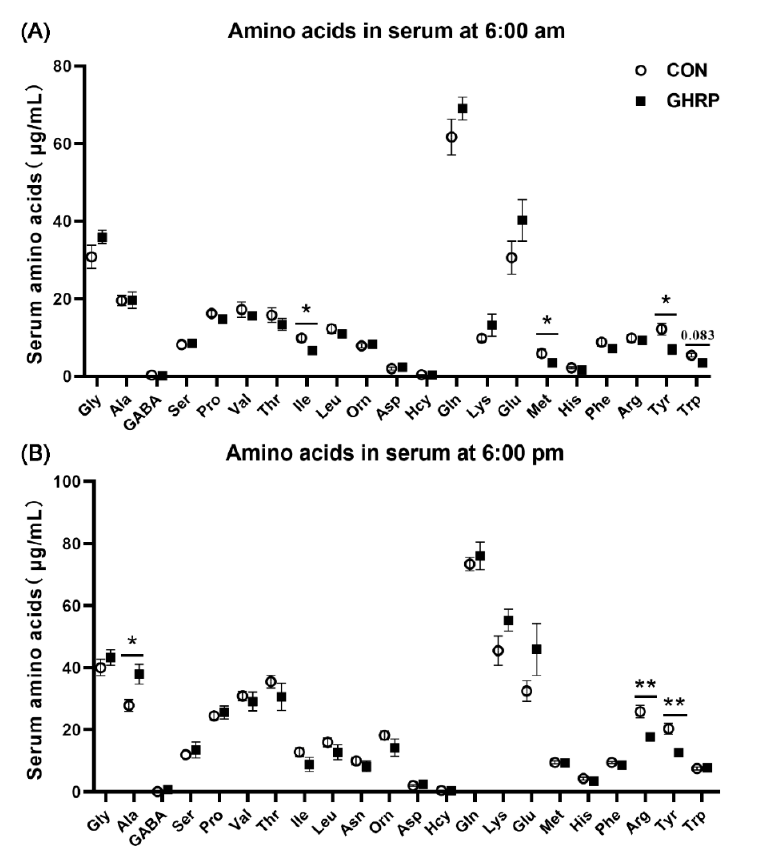
Figure 3. The serum concentrations of amino acids of pigs in the control group (CON) and ghrelin antagonist group (GHRP) at 6:00 ( A ) and 18:00 ( B ). Values are means ± SEMs; n = 6. * p < 0.05 versus control group; ** p < 0.01 versus control group.